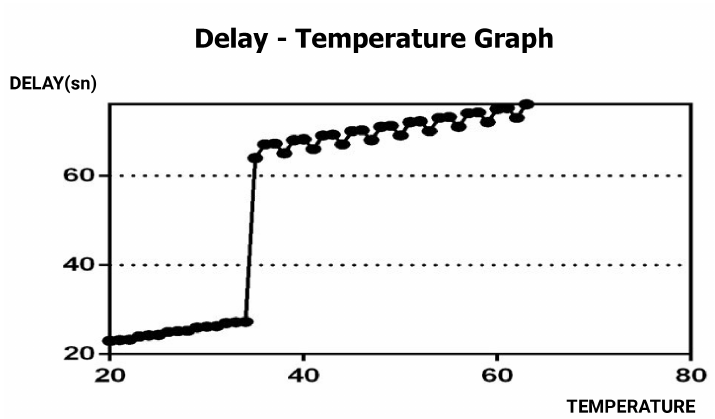
Figure 11. Variation of the delay time according to